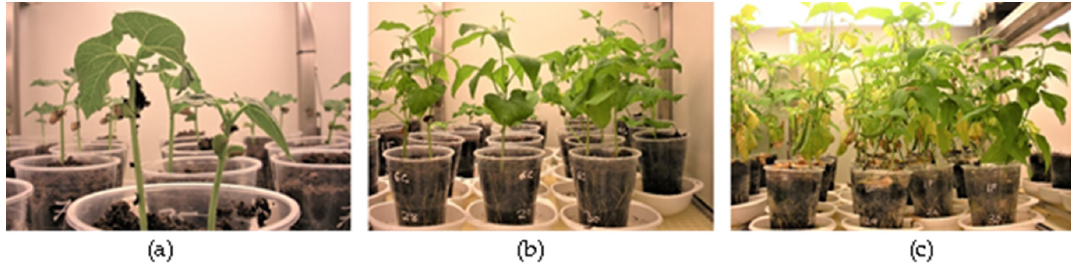
Figure 1. Bean sampling stages. ( a ) 14 DAS, ( b ) 35 DAS, and ( c ) 56